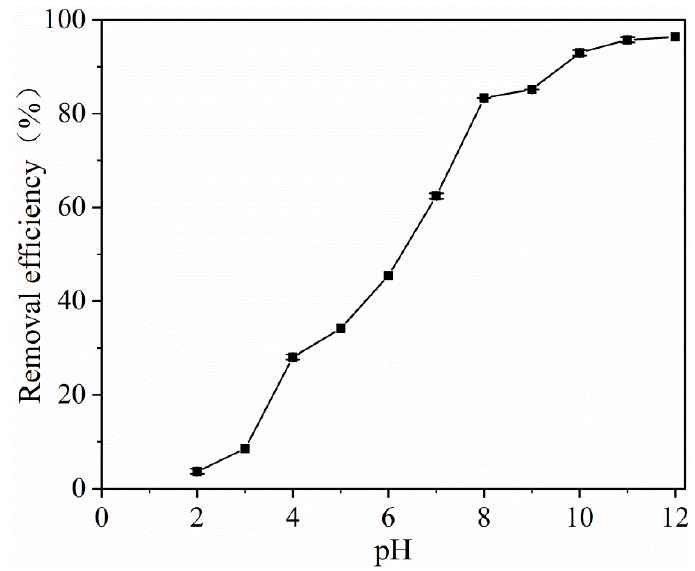
Figure 3. pH effect on the adsorption of tetracycline. ( C 0 = 20 mg L − 1 , V = 10 mL, m (adsorbent) = 20 mg, T = 25 °C, t = 120 min).